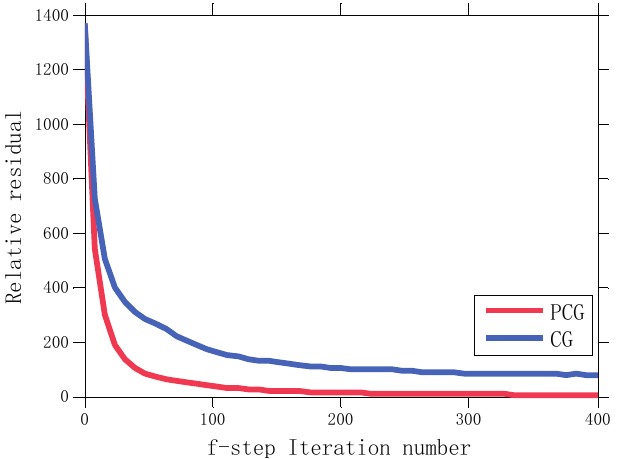
Figure 15. A comparison of the convergence rate in f step between PCG (with preconditioners) and CG (without preconditioners) in Figure 5a. Evolution of the relative residuals with iterations in the first f step is presented as an example.